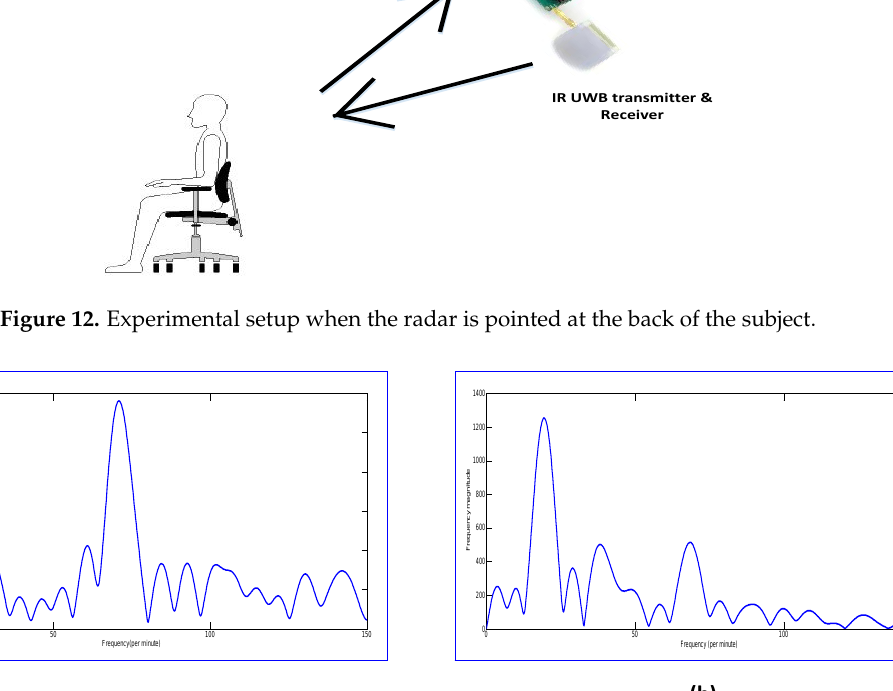
Figure 13. Spectrum of the signal reflected from backside of the person. ( a ) when a person is in normal relaxed mode; and ( b ) when a person is examined after heavy exercise and breathing heavily.